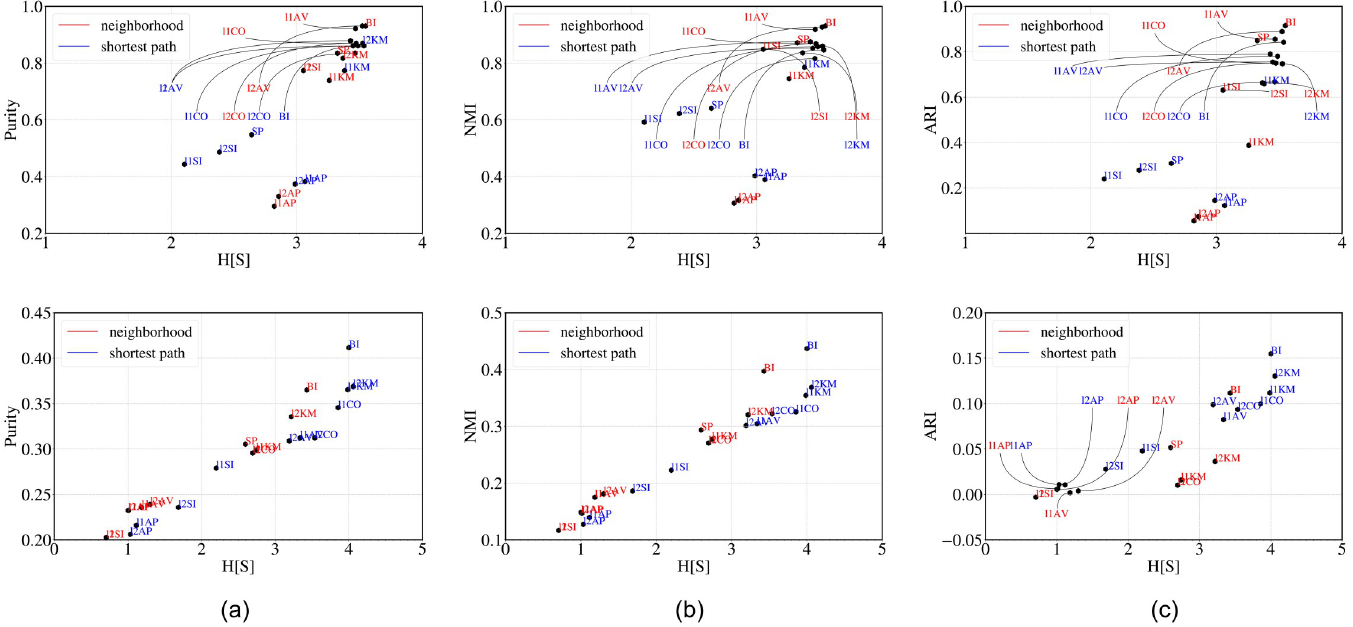
Fig 5. H[S] versus purity, NMI and ARI for (i) football (top) and (ii) railway (bottom). We consider two types of feature vectors for each data point (node). In case of ‘neighborhood” (represented in blue) the feature vector of each node u i consists of 1s and 0s depending on whether u j ( j 6¼ i ) is a neighbor or not. For ‘shortest path” (represented in red) the feature vector of each node ui consists of the shortest path to u